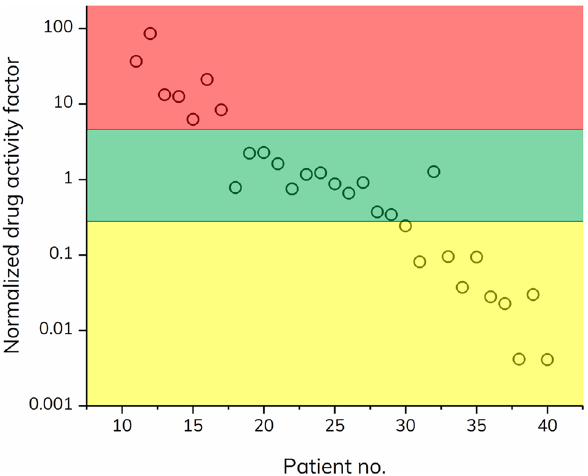
Figure 4. Visual representation of normalized drug activity factor (DAF Norm ) for as patient number 11–40 from the experimental group (30 patients). Again, the red, green, and yellow color zones correspond to patients classified as NAb positive, normal responders, and non-NAb positive,